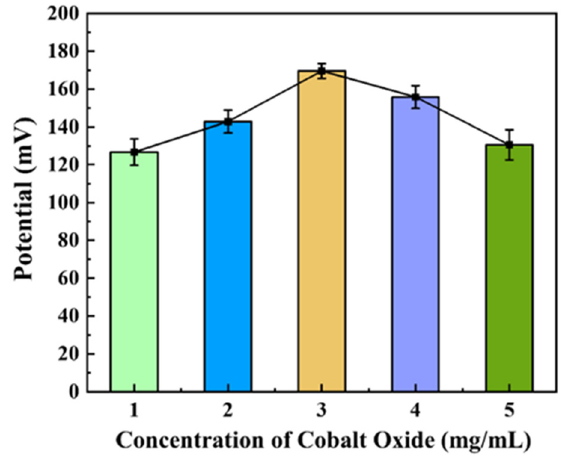
Figure 2. Potentials at various Co 3 O 4 concentrations.